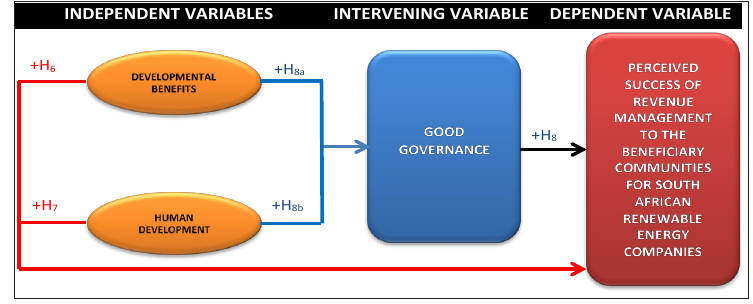
Figure 2: Path diagram of causal relationships: Revised theoretical model (Sub- model – Transformational change) Two variables, namely education and infrastructure development, loaded together to form a factor labelled “developmental benefits” (DEVB). The independent variable of change management was removed from the proposed theoretical model because its discriminant validity could not be confirmed by the exploratory factor